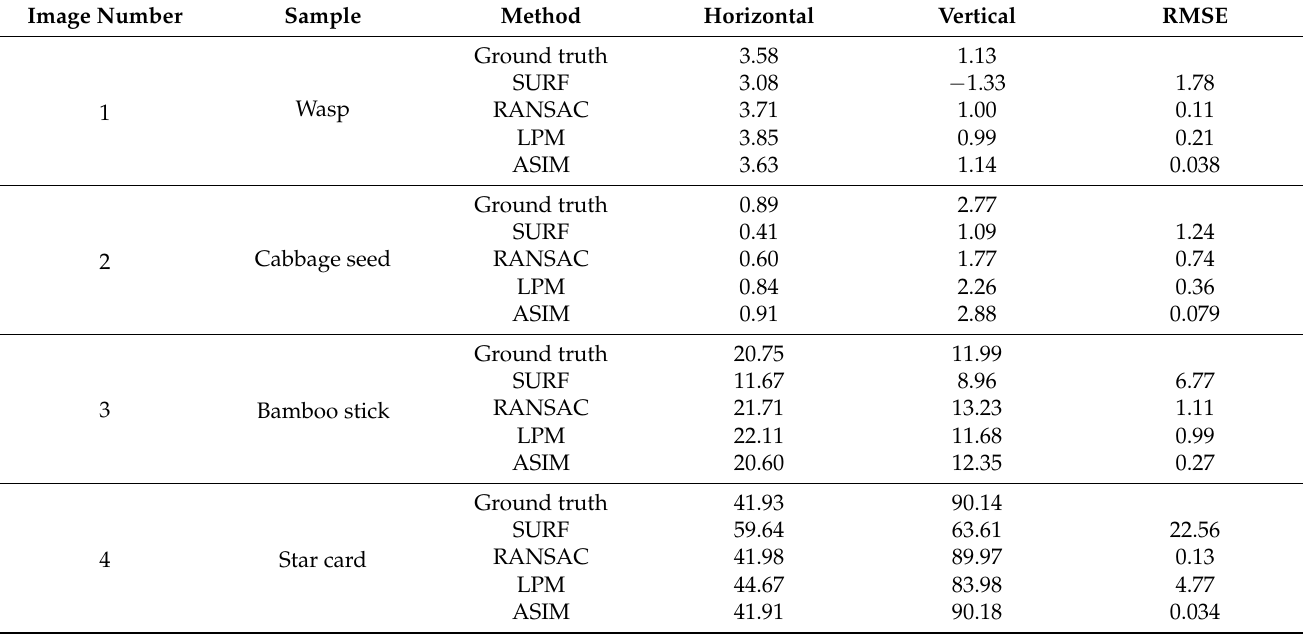
Table 5. Feature point elimination